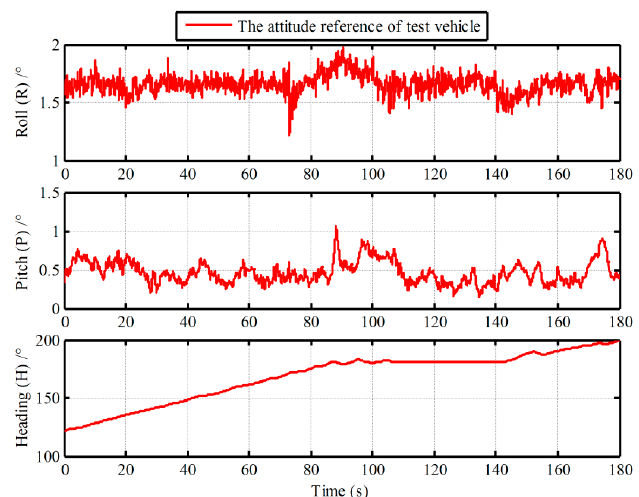
Figure 10. True attitude reference of vehicle experiment.